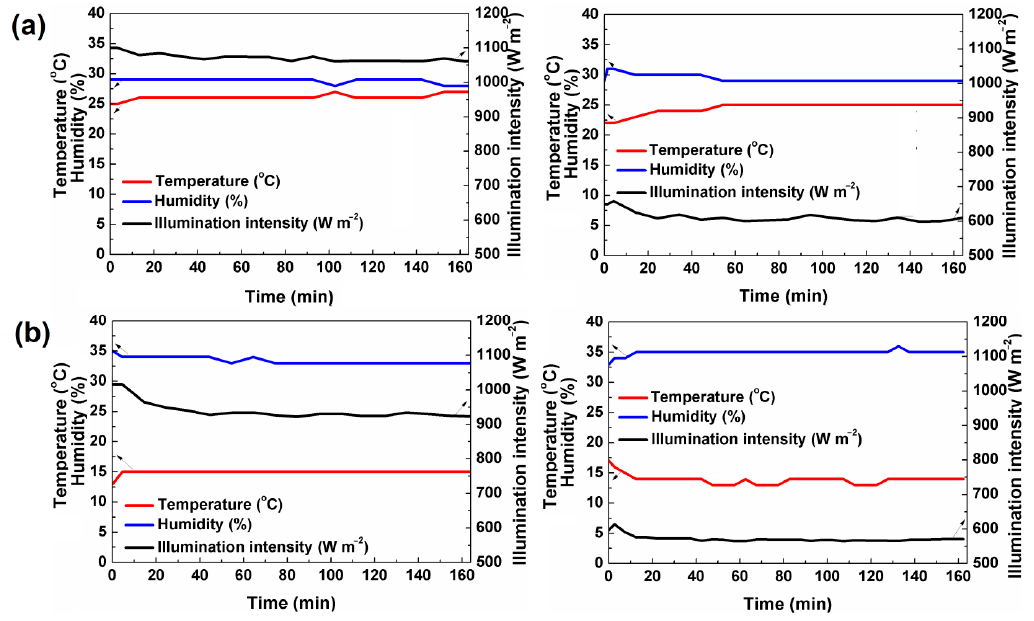
Figure 5. Environmental conditions during charging of a supercapacitor charger model using two 70 mm × 50 mm PV cells connected in parallel at a temperature of 25 °C ( a ) and 15 °C ( b ) under solar irradiance of 1000 W m − 2 and 600 W m − 2 (right side).